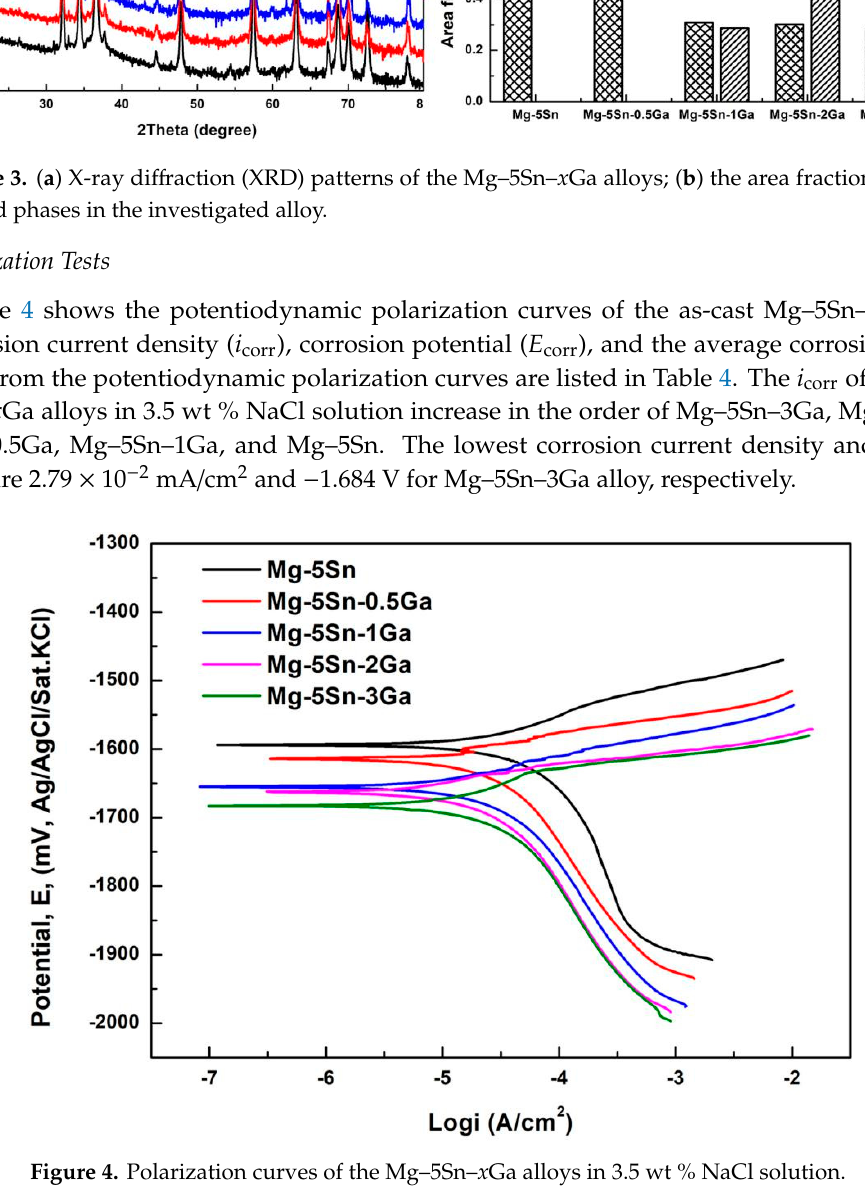
Figure 3. ( a ) X-ray di ff raction (XRD) patterns of the Mg–5Sn– x Ga alloys; ( b ) the area fraction of the second phases in the investigated alloy.